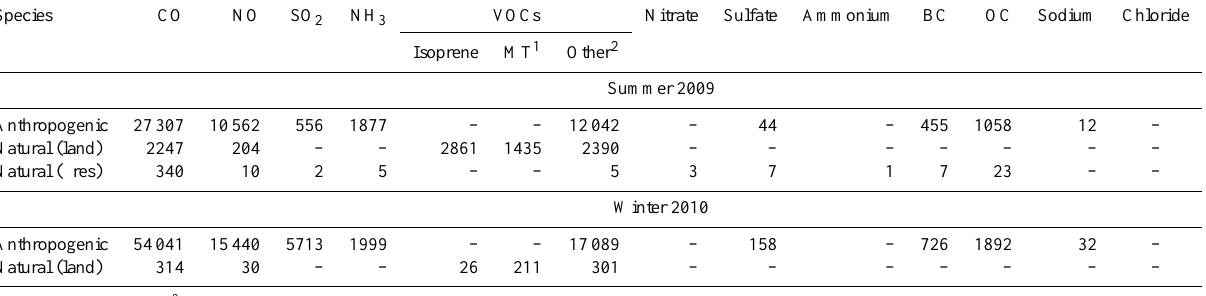
Table 1. Emission mass totals (in tons/month) for the Paris greater area as shown in Fig. 1. Species